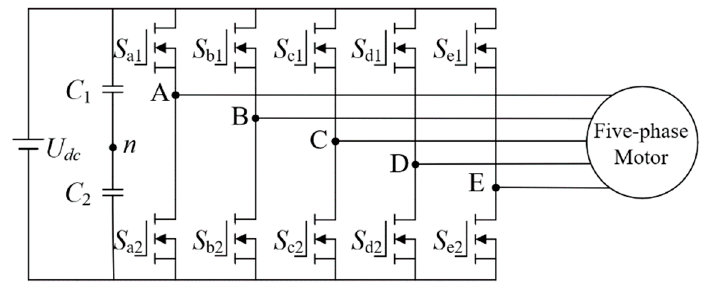
Figure 17. The topology of the five-phase half-bridge inverter.